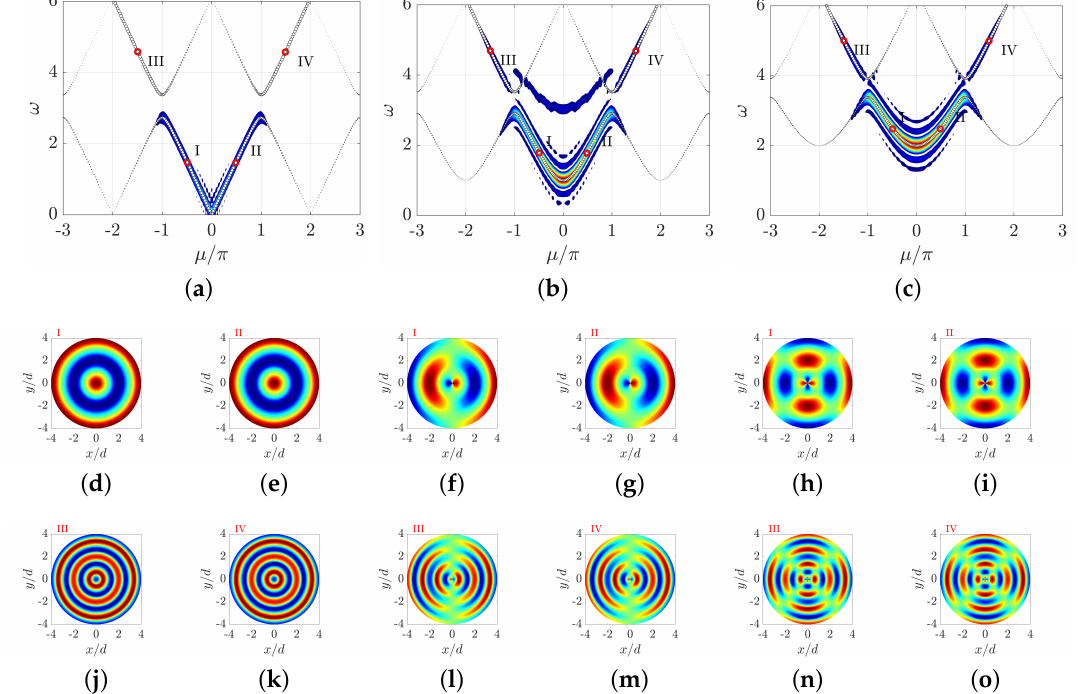
Figure 3. Numerical dispersion (colored contours) with superimposed Plane Wave Expansion Method (PWEM) solution (white dots) for ( a ) q = 0, ( b ) q = 1, ( c ) and q = 2. The Bloch-wave solutions corresponding to µ / π = ± 0.5 and µ / π = ± 1.5 are marked with red dots. The corresponding modes are illustrated below for ( d , e , j , k ) q = 0, ( f , g , l , m ) q = 1, and ( h , i , n , o ) q =